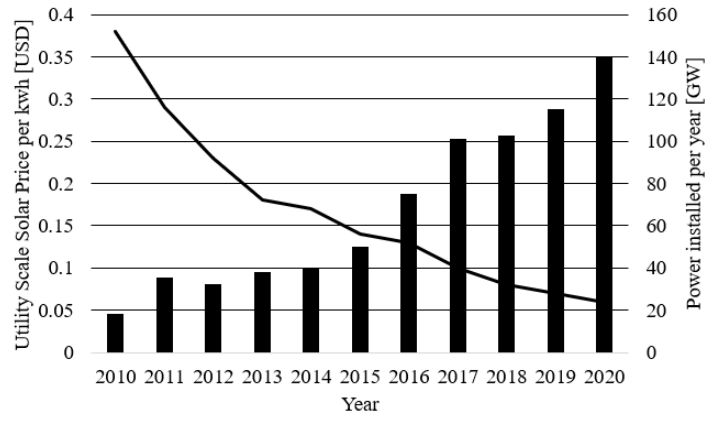
Figure 1. Utility Scale Solar Price vs. GW installed per year. Source [3], own elaboration.